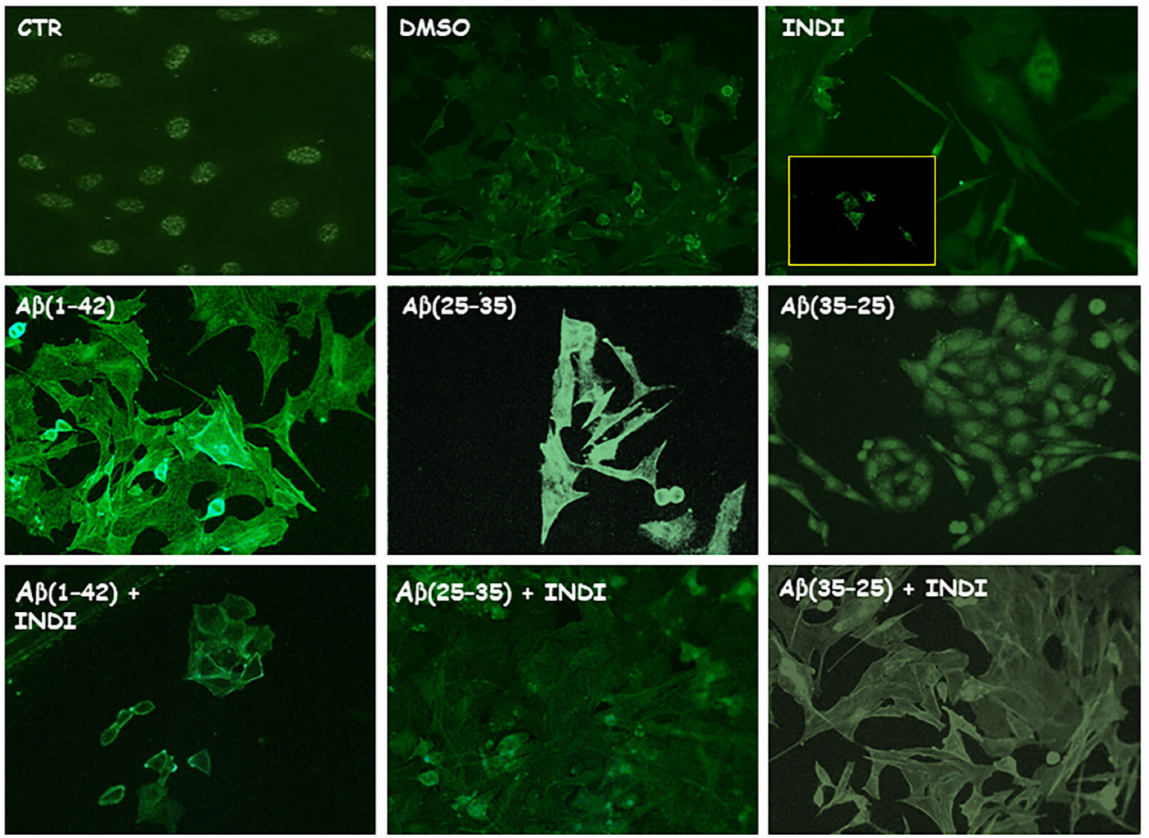
Figure 3. Immunocytochemistry for anti-GFAP in OECs. Images show different conditions: control, DMSO, 100 µ M Indicaxanthin (INDI), 10 µ M A β (1-42) or A β (25-35) or A β (35-25) both in the absence and presence of 100 µ M INDI for 24 h. Scale bar 20 µ